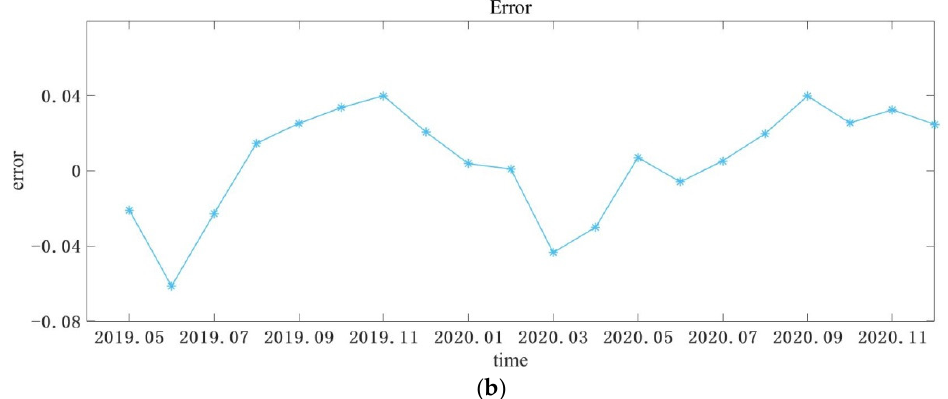
Figure 3. Sales fitting chart and error chart of Suteng. Figure 3. ( a ) Sales fitting chart and ( b ) error chart of Suteng.